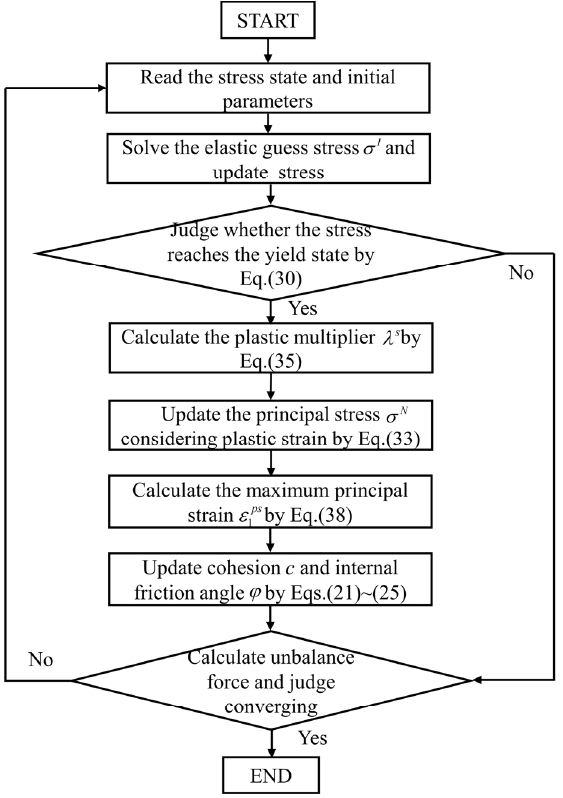
Figure 8. Flow chart of the secondary development of the constitutive